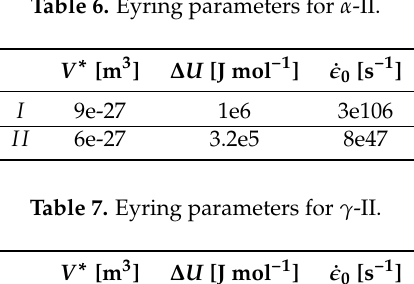
Table 6. Eyring parameters for α -II.